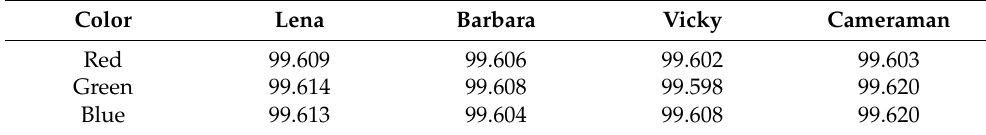
Table 5. NPCR of the test images after encryption.